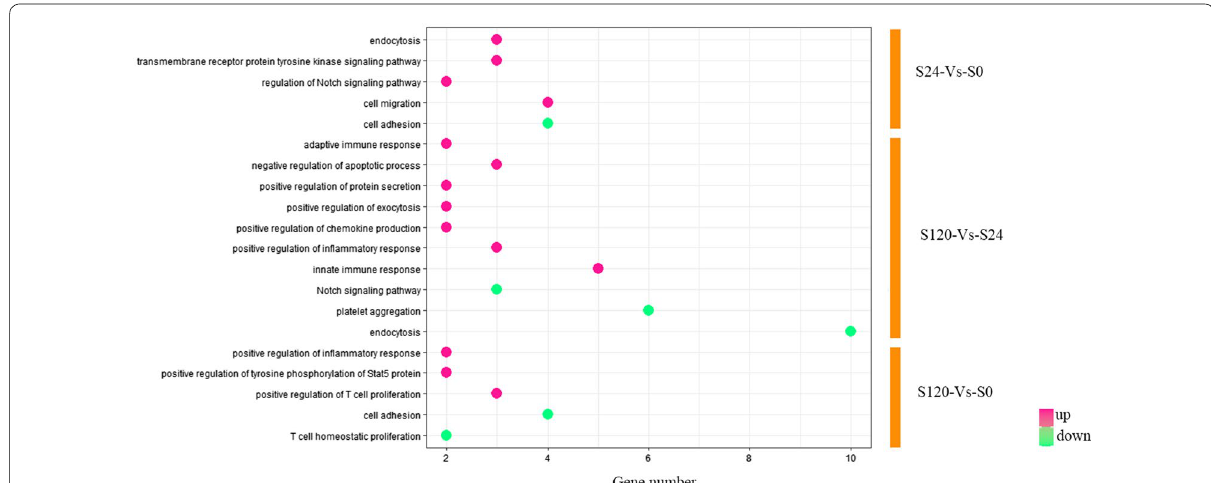
Fig. 3 The regulation of DEPs by GO annotation analysis. GO term is the X-axis and the numbers of genes are the Y-axis. The P value < 0.05 were defined